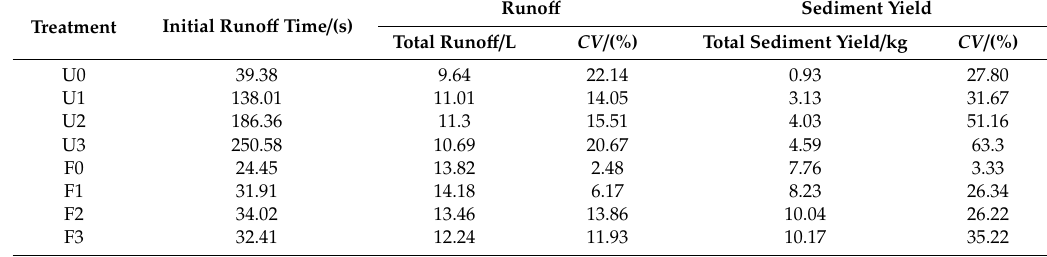
Table 2. Initial runo ff time, runo ff and sediment yield under di ff erent treatments.